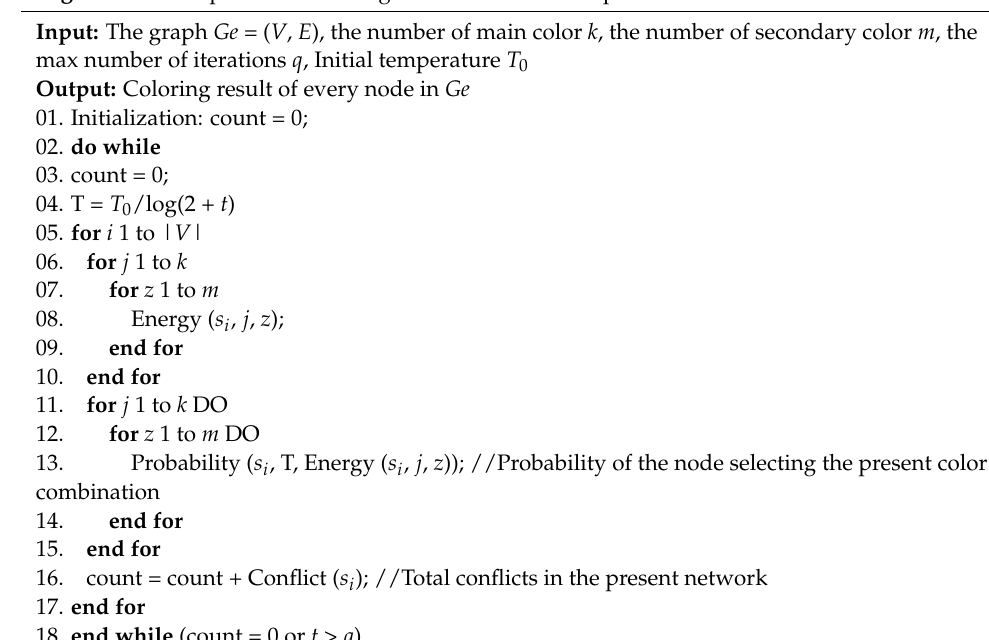
Algorithm 2. Graph vertex coloring based on the Gibbs optimization.